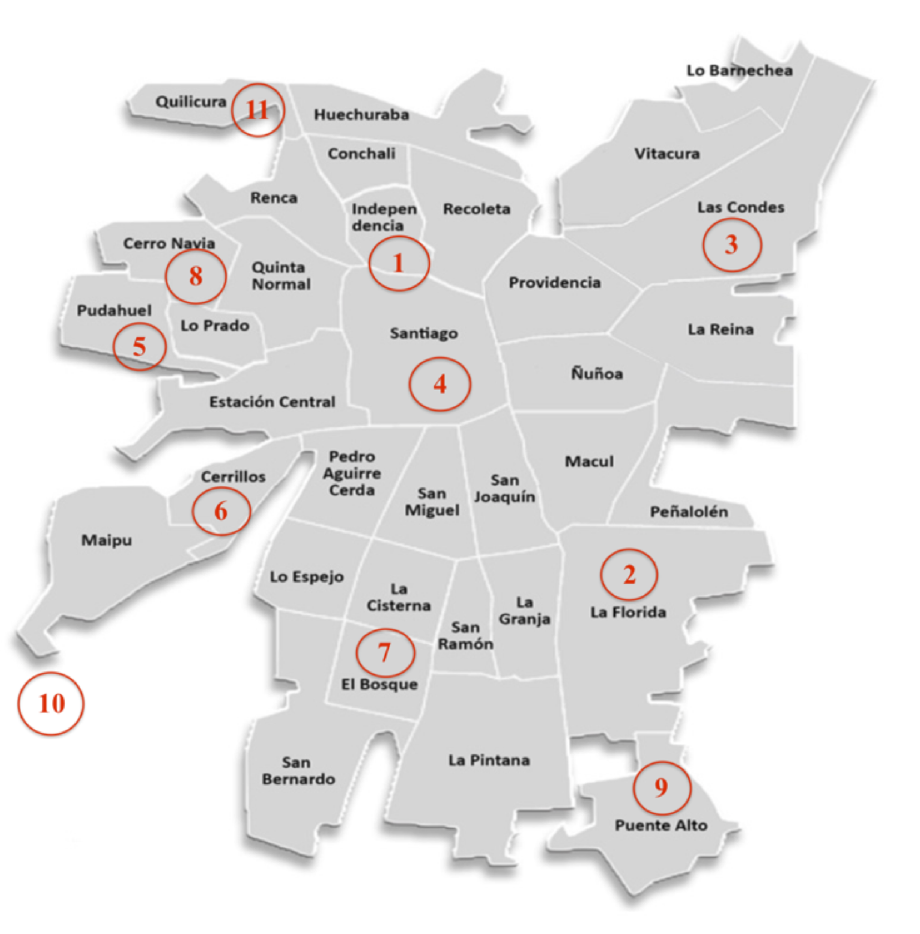
Figure 1. Air quality monitoring stations of the MACAM network in the metropolitan region of Santiago,